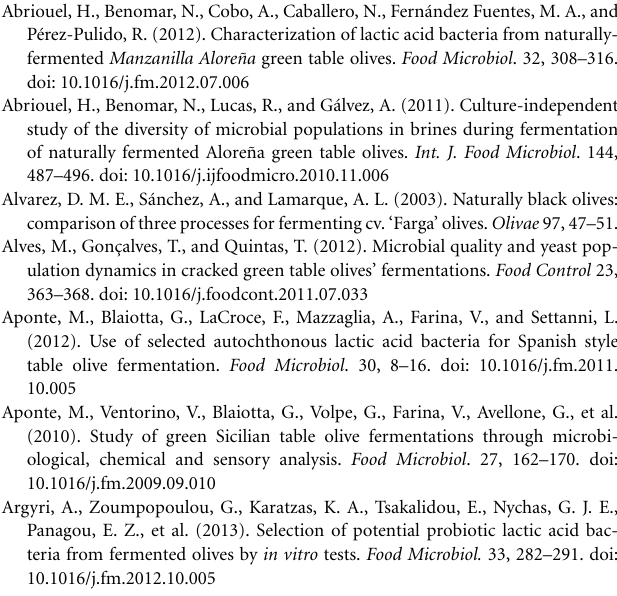
cultures for table olives: a step-by-step procedure. Front. Food Microbiol . 3:194. doi: